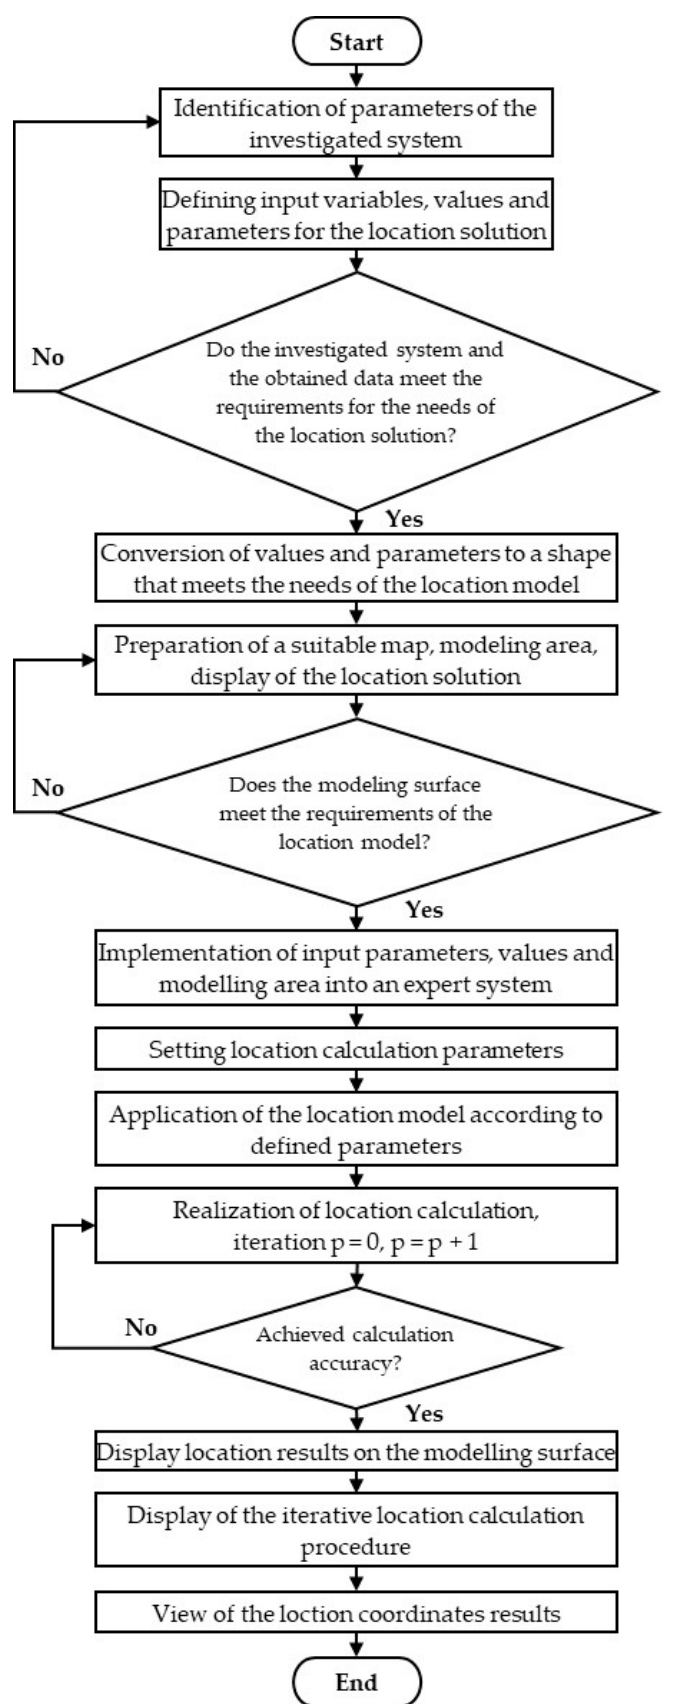
Figure 1. Steps of the calculation procedure.